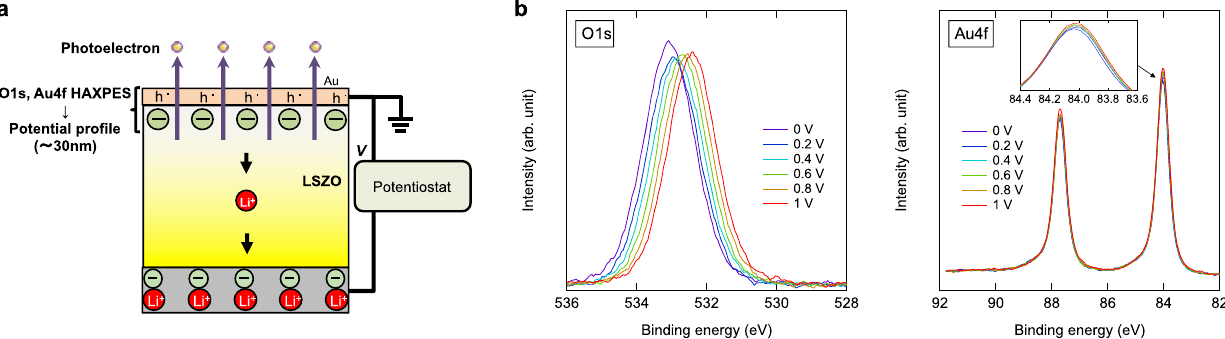
Fig. 7 In situ hard X-ray photoelectron spectroscopy observation at the Au electrode/LSZO interface. a Illustration of the two terminal cell with Au top electrode, LSZO electrolyte, and LCO/Pt bottom electrode for in situ HAXPES. Li + in the electrolytes is shown only as indicators of the polarity of the electric current. b O 1 s and c Au 4 f HAXPES spectra measured under various voltage applied conditions (0 to 1 V). Inset of c is a magni fi cation of Au 4f 7/2